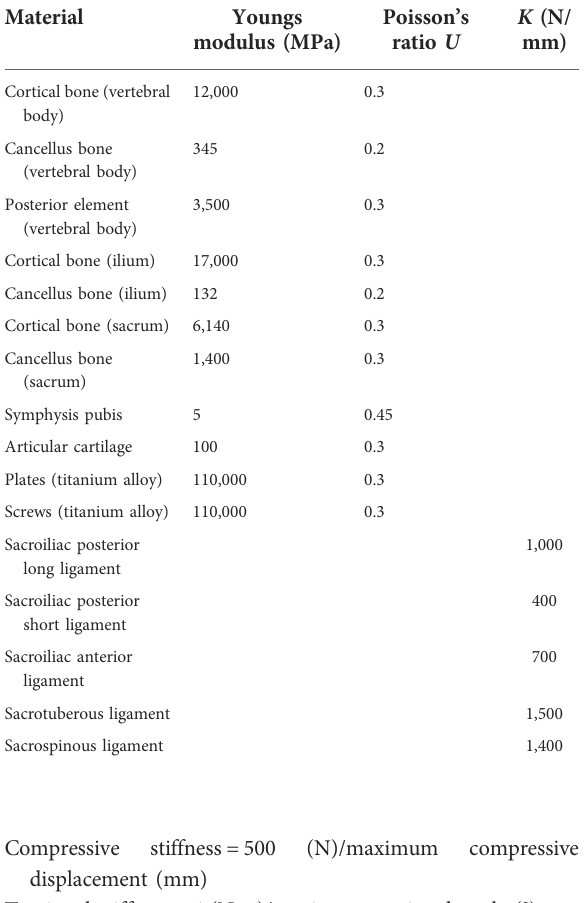
TABLE 2 The properties of material used in fi nite element model.